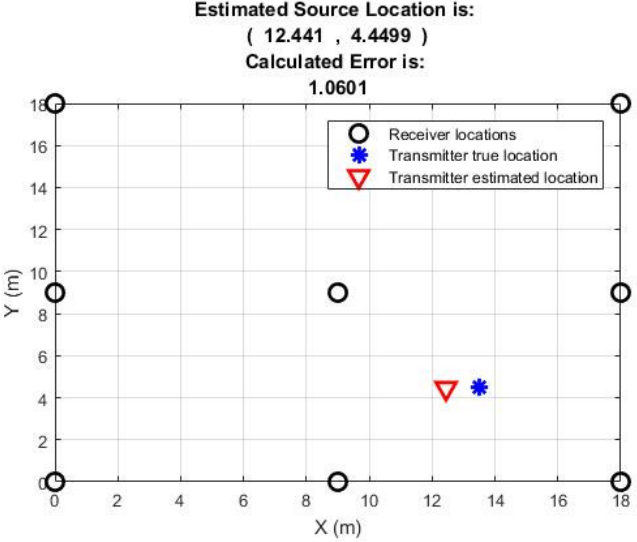
Figure 10. Position 1 result of the estimated source location with eight receiving nodes.